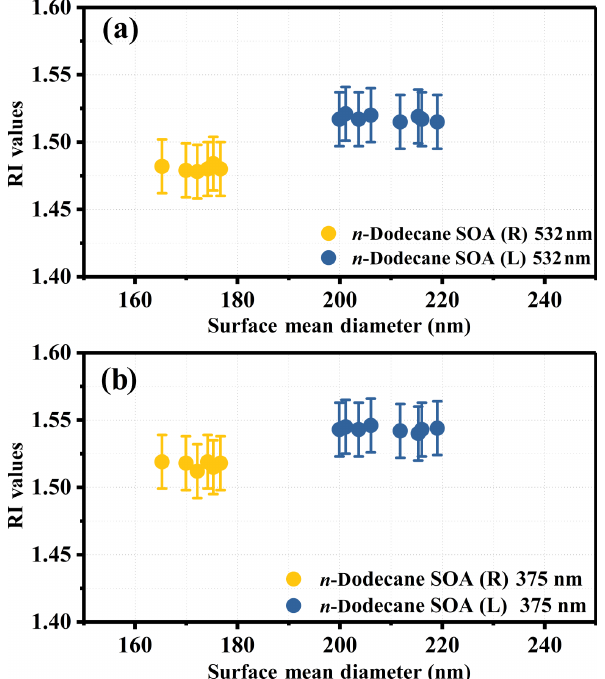
Figure 2. Variation tendency of the RI values as a function of the surface mean diameter for SOA produced at room temperature and under low-temperature conditions at (a) 532nm and (b) 375nm.